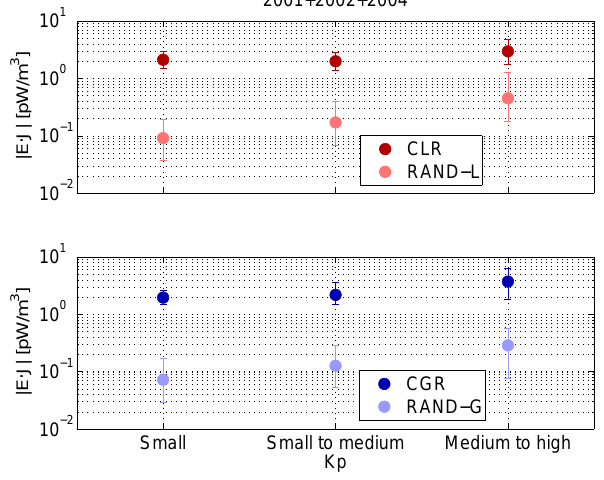
Fig. 5. The energy conversion strength at Cluster plasma sheet al- titudes versus Kp. The strength is measured as the median of the magnitude of the average power density within the same Kp bins as in Fig. 2 ( 0 ≤ Kp ≤ 2 , 2+ ≤ Kp ≤ 4 , and 4+ ≤ Kp ≤ 9+ ). The error bars indicate the 25% and 75% percentiles. Red and light red correspond to CLRs and RAND-Ls (top panel), while blue and light blue correspond to CGRs and RAND-Gs (bottom panel).